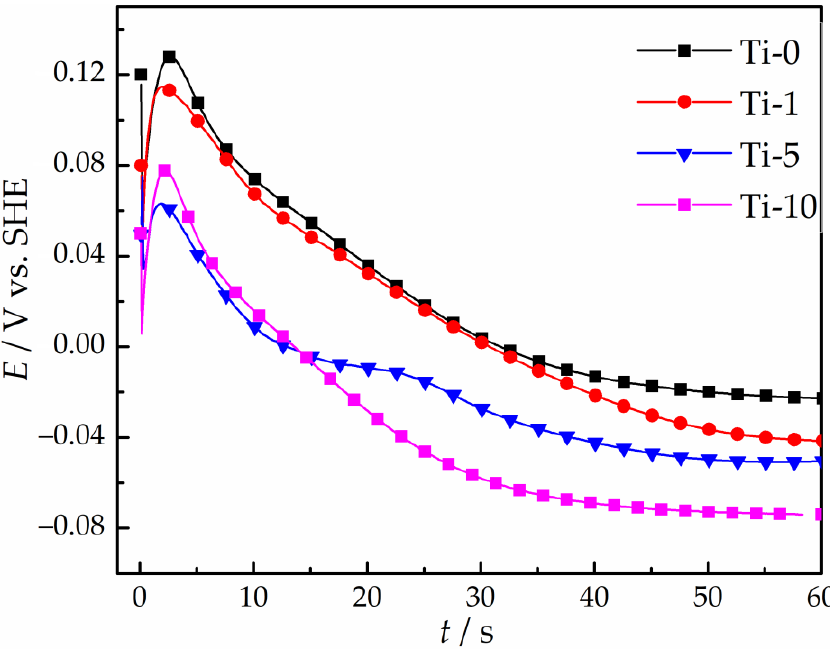
Figure 3. Chronopotentiograms of copper electrode in sulfate solutions obtained at the cathodic current density of −0 .015 A/cm 2 .